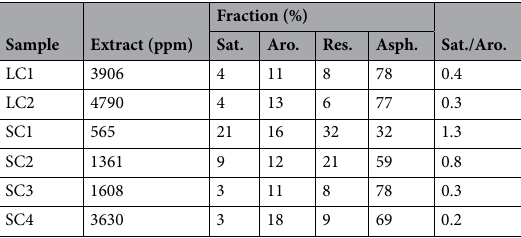
Table 2. Results of Soxhlet extraction and compositional fractions of bitumen. Sat. saturated hydrocarbons, Aro. aromatic hydrocarbons, Res. Resins, Asph. asphaltenes.